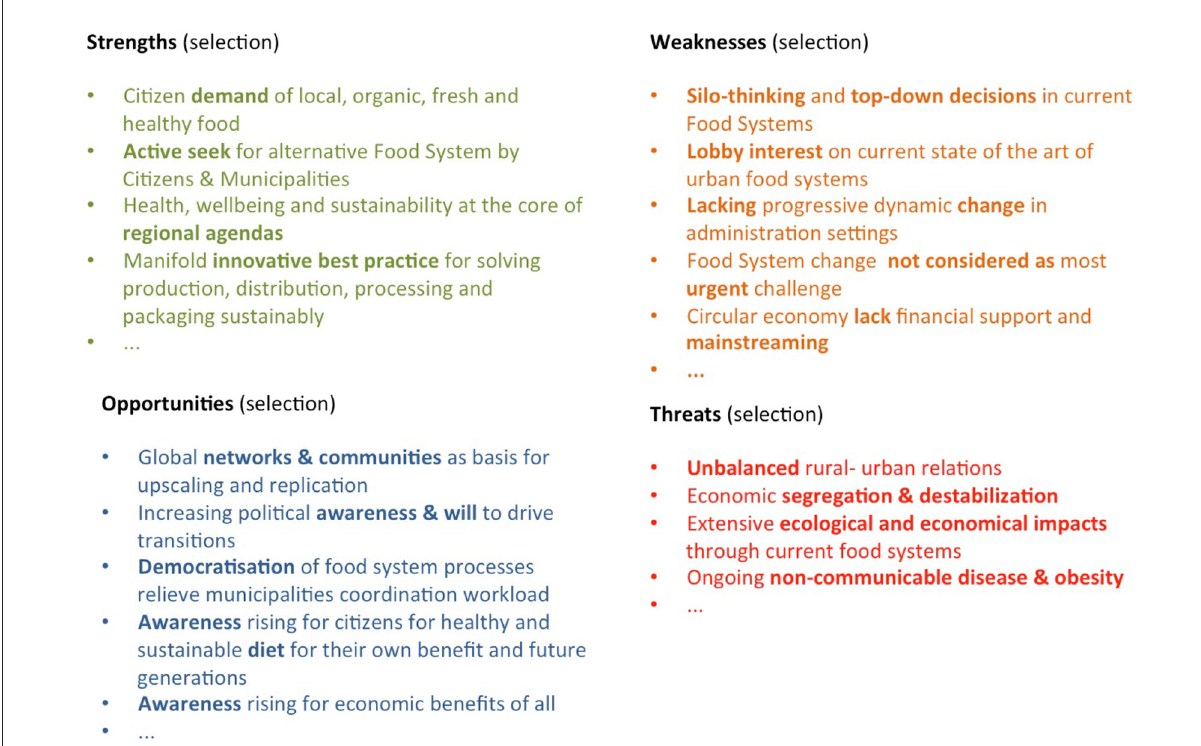
FIGURE4 Analysis of strengths, weaknesses, opportunities and threats of current City Region food systems across the case